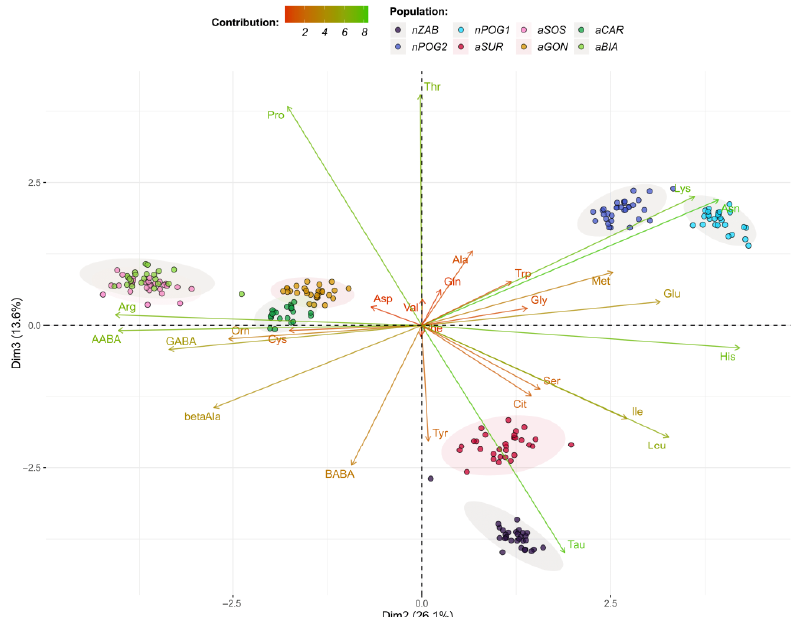
Figure 6. Biplot of amino acid profiles for the anthropogenic (aBIA, aCAR, aGON, aSOS, and aSUR) and natural (nPOG1, nPOG2, and nZAB) populations of Epipactis helleborine , showing the first two dimensions/factors (Dim2-3) of the PCA that together explain 39.7% of the variance. The biplot vectors indicate the strength and direction of factor loading for the first two factors. Individuals (populations) are color-coded by population. The ellipses around the individuals show an assumed 95% multivariate normal distribution.